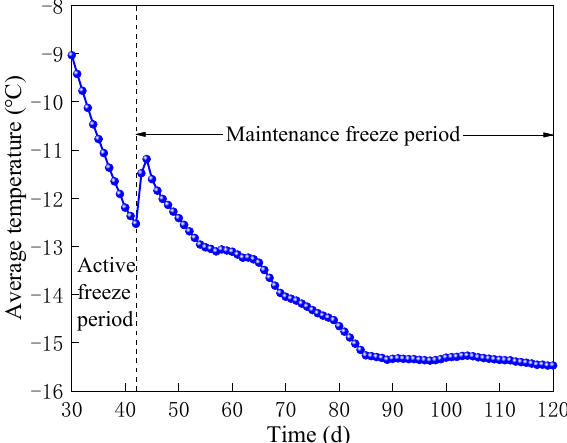
Figure 11. Average temperature of effective frozen wall.